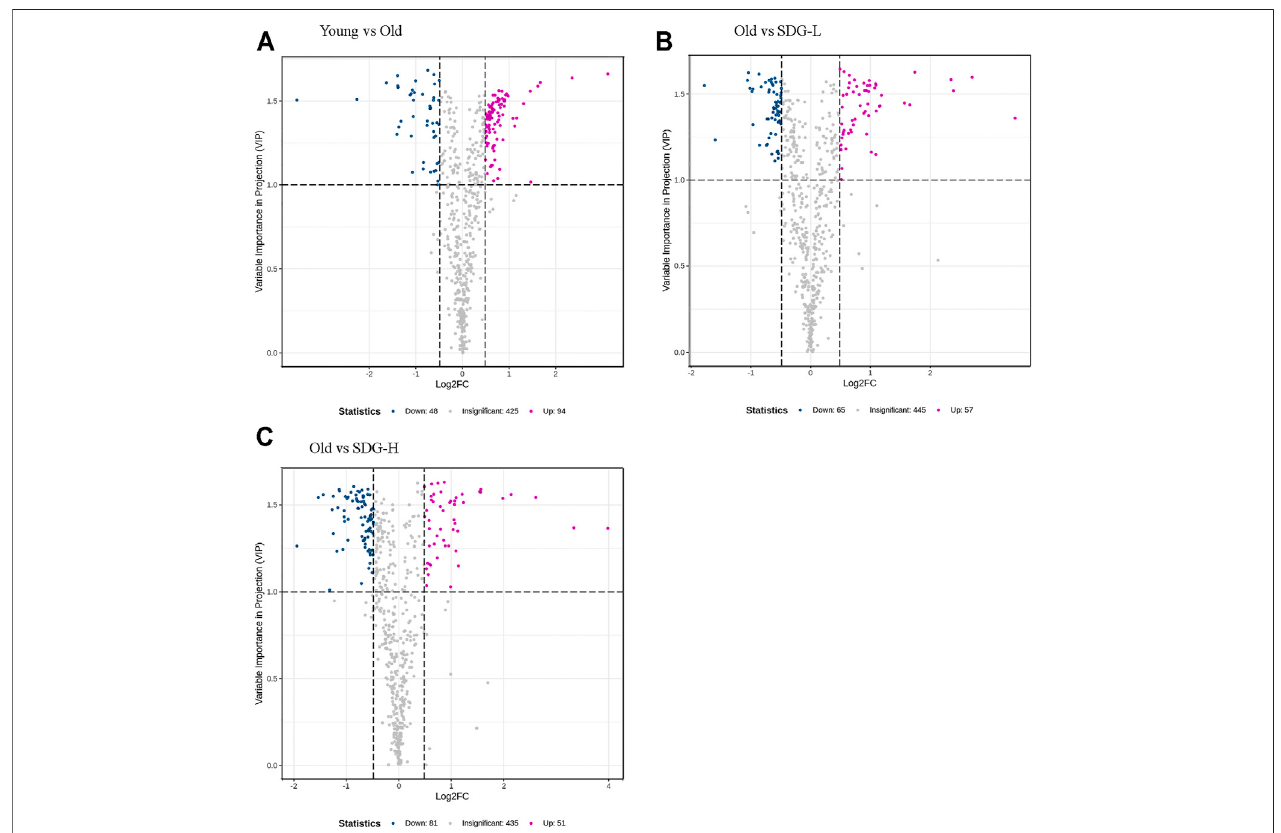
FIGURE4| Filtereddifferentialmetabolitesintheovariesofmiceindifferentgroups.ThecomparisonsoftheYoungandtheOld (A) ,theOldandtheSDG-L (B) and the Oldand theSDG-H (C) wereanalyzed.Each point inthevolcanomap representsametabolite,theabscissarepresentsthelogarithm ofthequantitativedifferenceof a certain metabolite in the two samples; the ordinate represents the VIP value. The larger the absolute value of the abscissa, the greater the difference between the two samples; the larger the ordinate value, the more signi fi cant and the more reliable the differential levels of metabolites. The blue dots in the fi gure represent downregulated differential metabolites, the magenta dots represent upregulated differential metabolites, and the gray dots represent the metabolites that are detected but not signi fi cantly different.